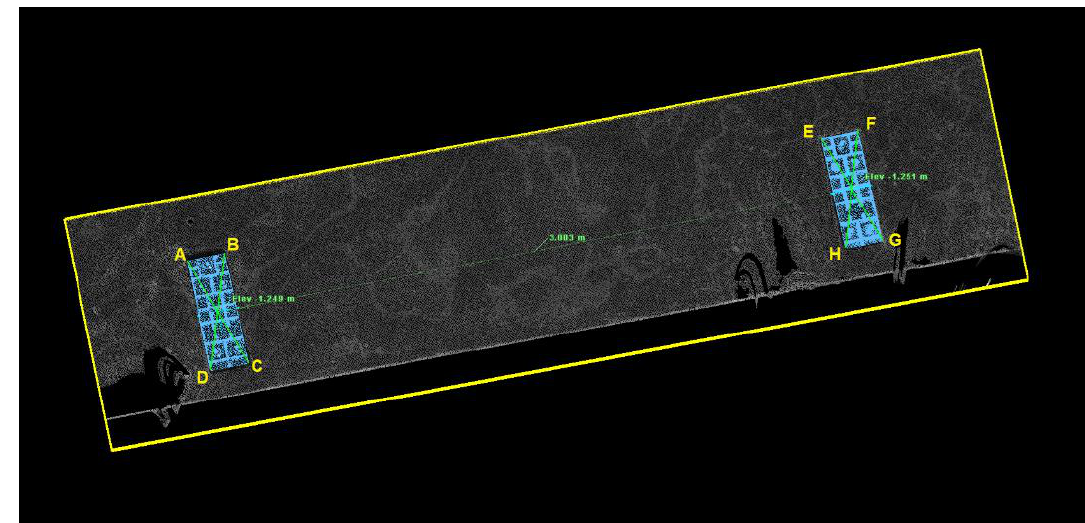
Figure 16. Design tolerance.